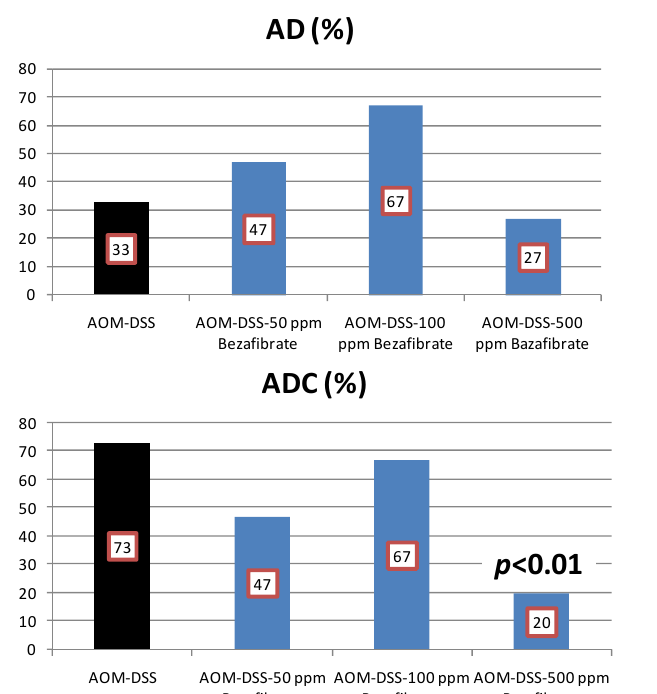
Figure 6. Incidences and multiplicities of adenoma (AD) and adenocarcinoma (ADC) in the bezafibrate